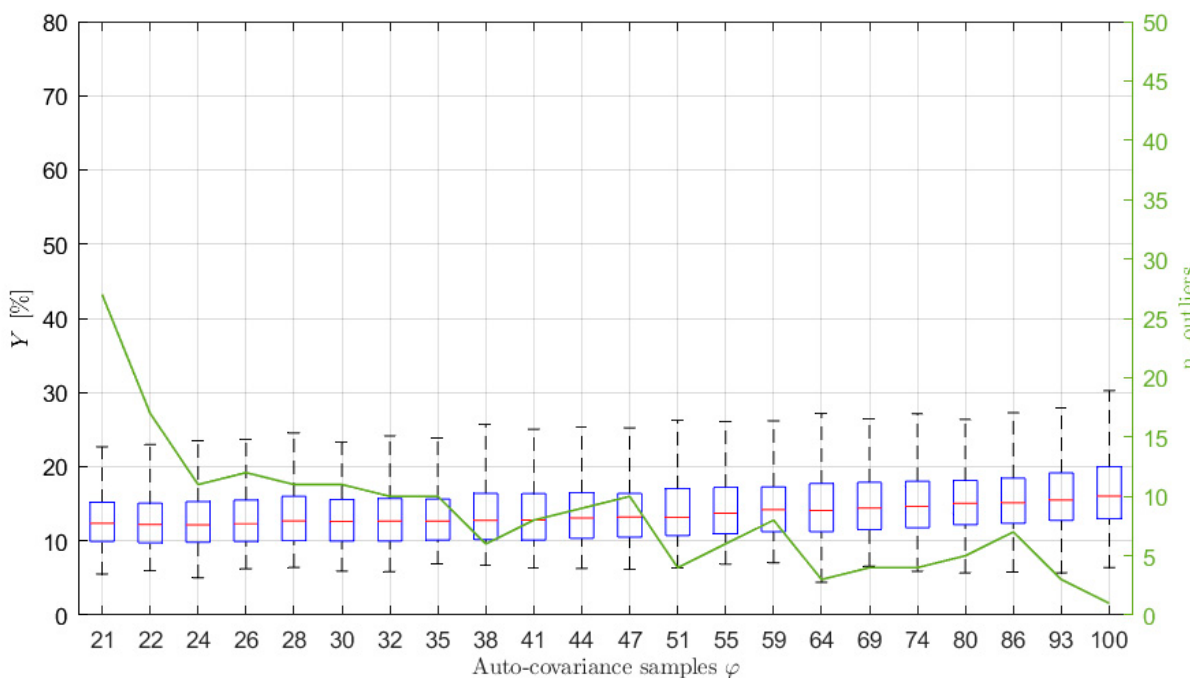
Figure 11. Box plot (left vertical axis) and number of outliers (solid line and right vertical axis) as functions of the number ϕ of auto − covariance samples used to write Equation (14) for sea state 2 in Table 1, ˆ p = 10, x 3600 s long and sampled at 1 Hz. The typical values of ˆ ϕ are between 23 and 27.